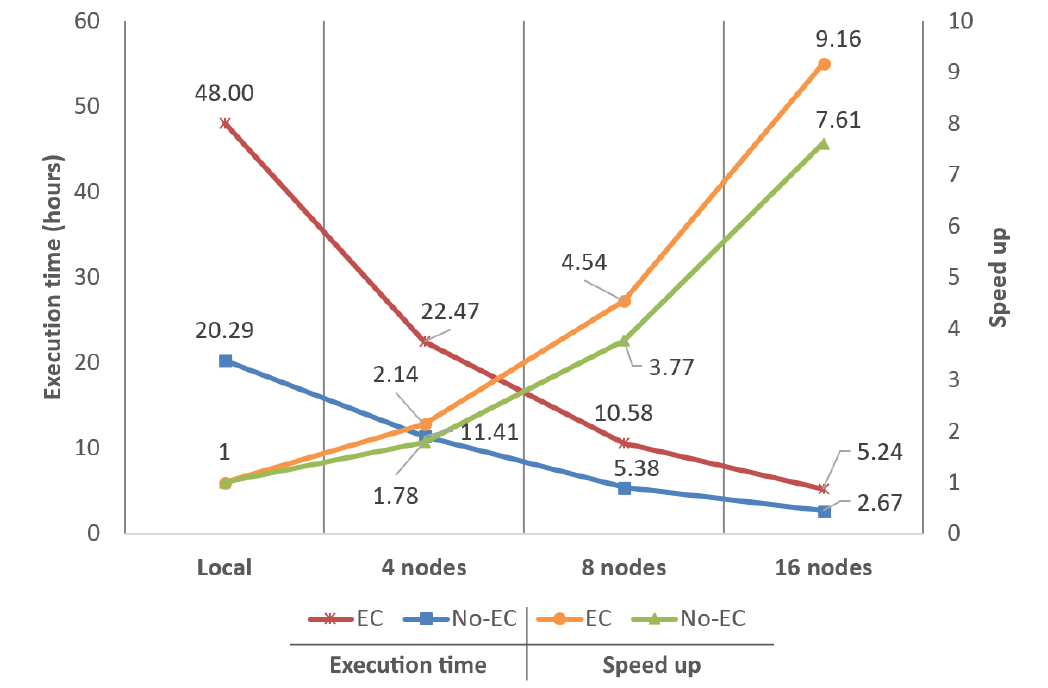
Figure 8. Performance analysis and scalability comparison using dataset D2 (100 ×